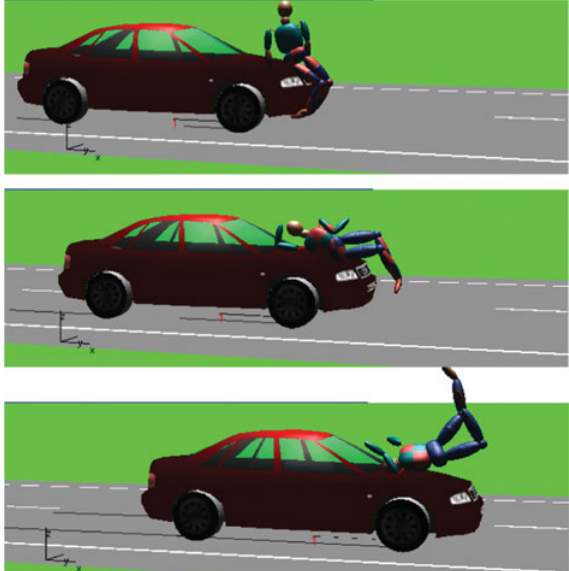
Fig. 10. Computer modelling of running over pedestrian ( PC-Crash